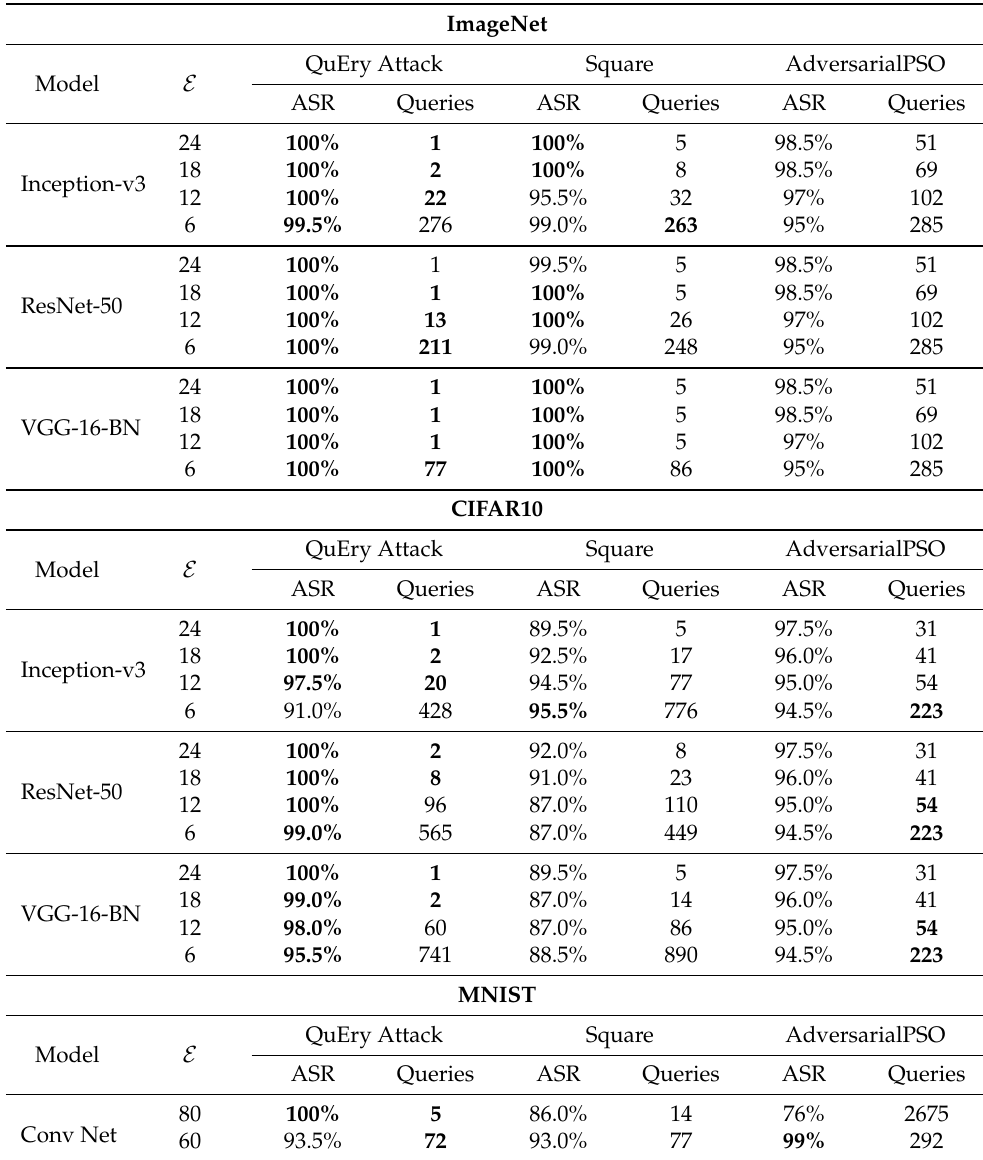
Table 1. Experimental results. ASR: Attack Success Rate. Queries: Number of model queries. Each value represents the median of 200 runs (images). Epsilon: E ∈ { 0 . . . 255 } (8-bits pixel values). Top results are marked in